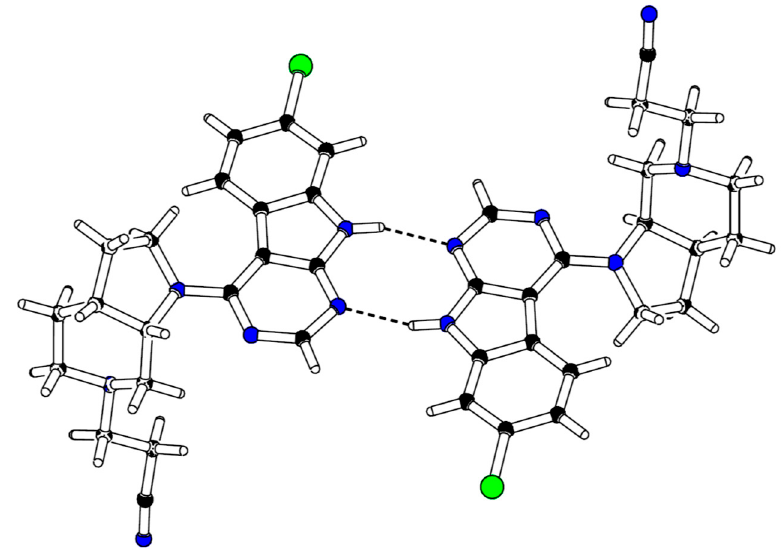
Figure 4. X-ray crystal structure of compound 24 .